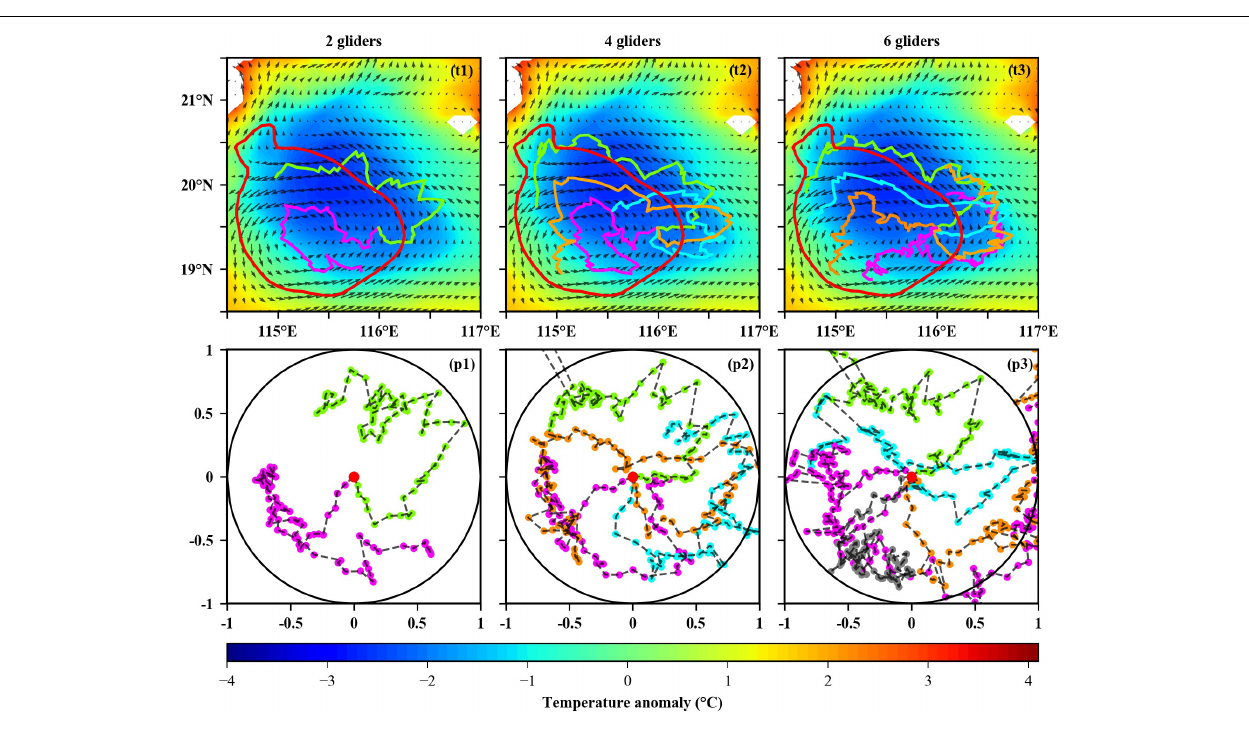
Frontiers in Marine Science |